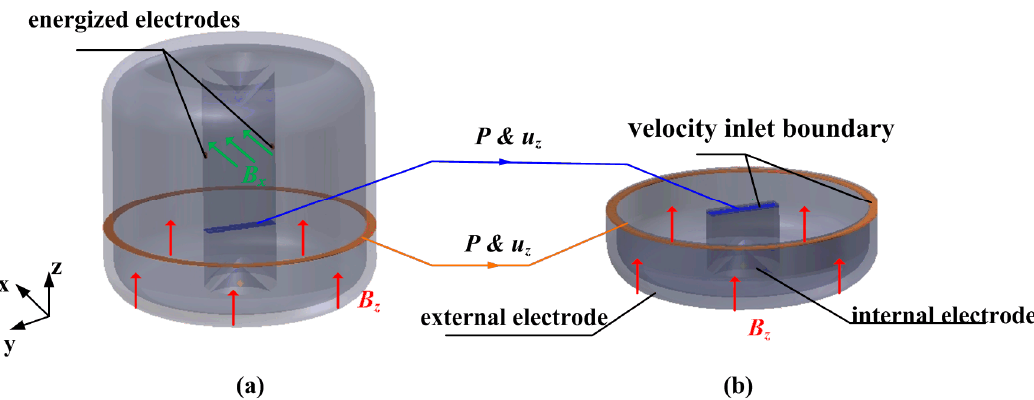
Figure 3. The computation domains with the two interaction solving methods. ( a ) fluid domain using the second electric approach ( b ) fluid domain using the first magnetic approach.